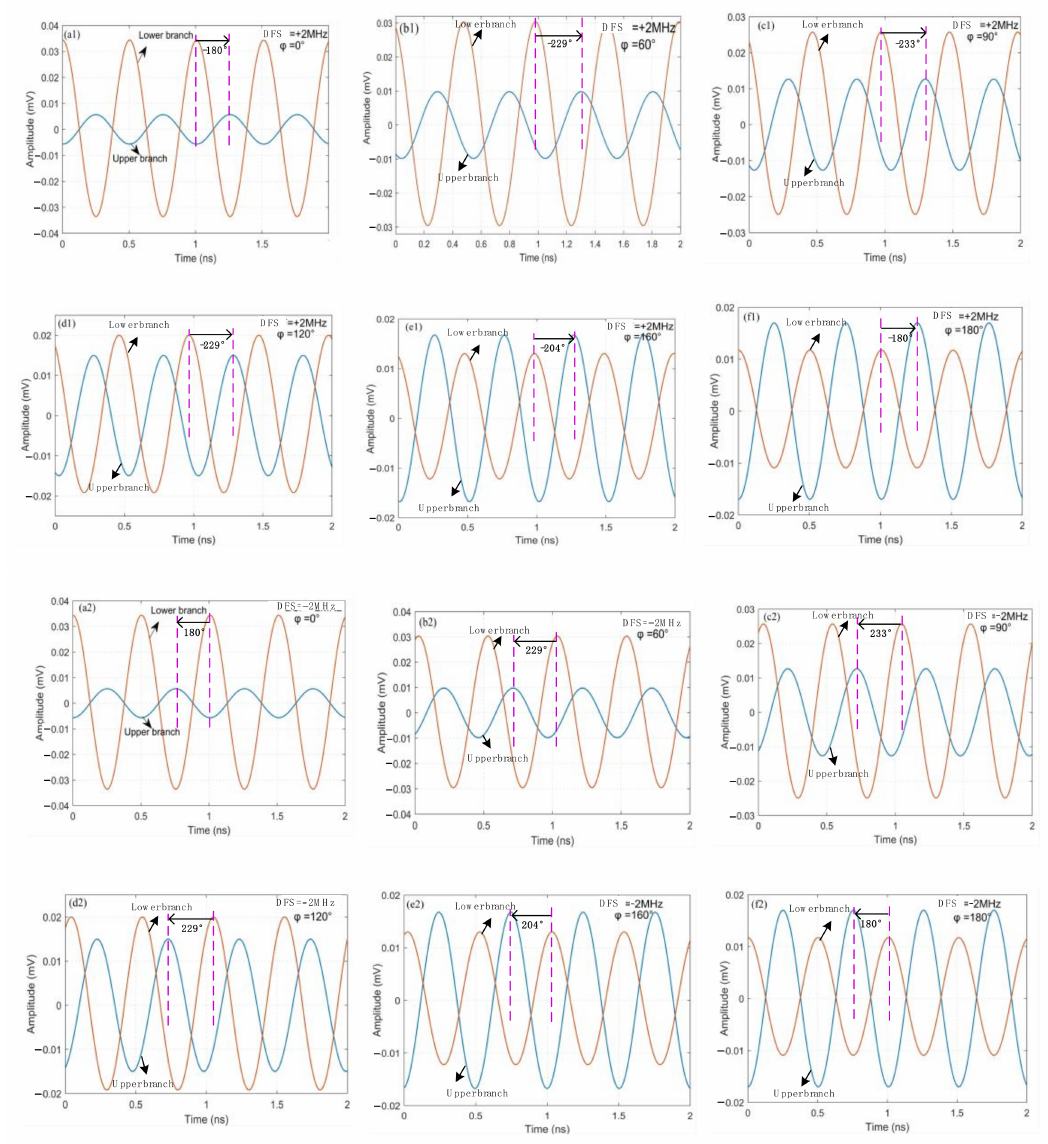
Figure 7. Waveforms of the upper branch and the lower branch for the DFS in different situations. ( a1 – f1 ) for the phase relationship between I upper and I lower when the DFS is +2 MHz and the phase difference between the echo signals is 0 ◦ , 60 ◦ , 90 ◦ , 120 ◦ , 160 ◦ and 180 ◦ , respectively. ( a2 – f2 ) for the phase relationship between I upper and I lower when the DFS is − 2 MHz and the phase difference between the echo signals is 0 ◦ , 60 ◦ , 90 ◦ , 120 ◦ , 160 ◦ and 180 ◦ , respectively. Some instability factors that may cause measurement errors, including the DC drift, the lower extinction ratio of two DDMZMs and phase shift caused by splitter, are